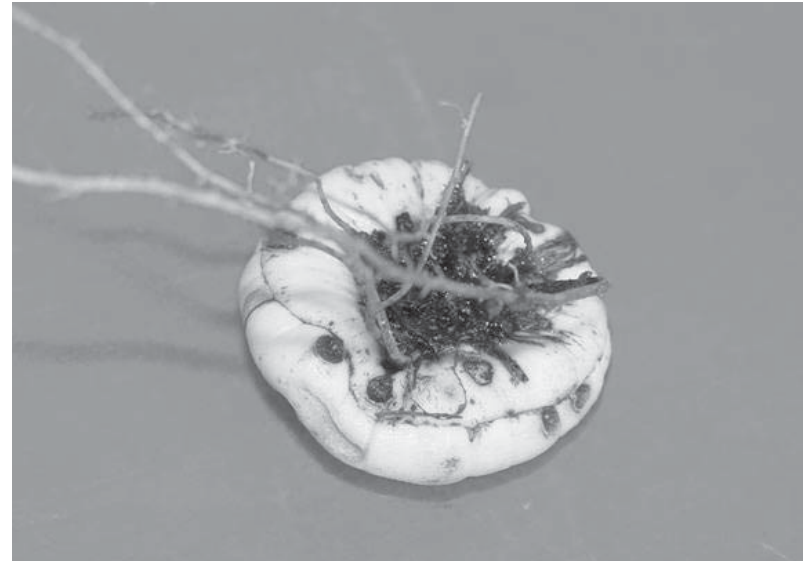
Fig. 3. Corm of gladiolus cv. White Prosperity infected with Fusarium oxysporum f. sp. gladioli and showing basal rot and also concentric lesions of brown